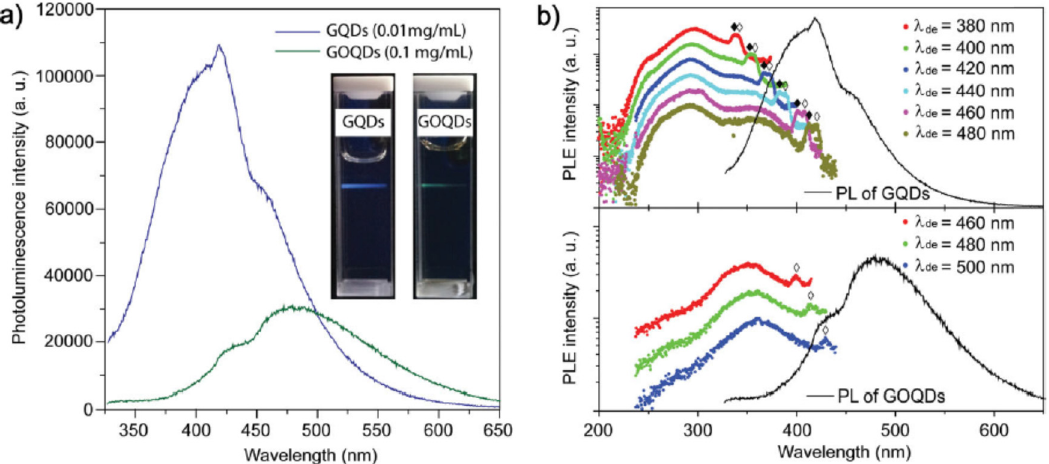
Figure 7: ( a ) PL spectra and the corresponding fl uorescent images of GQDs and GOQDs, ( b ) PL excitation spectra of GQDs and GOQDs with varying detection emission wavelengths [ 91 ]